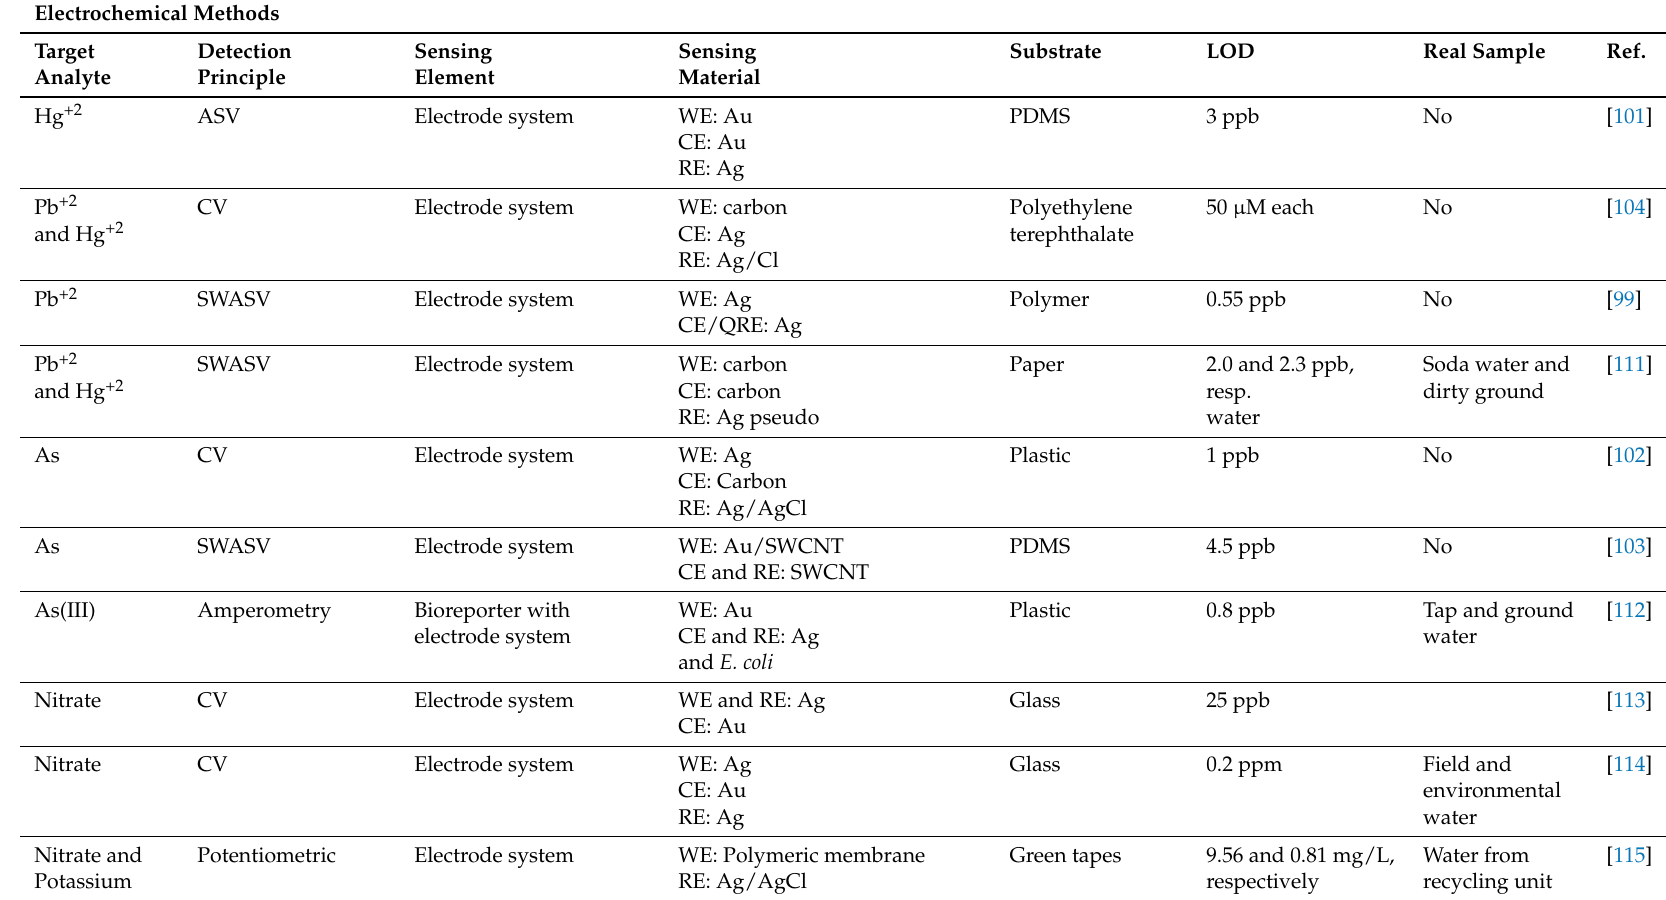
Table 2. Comparison of electrochemical